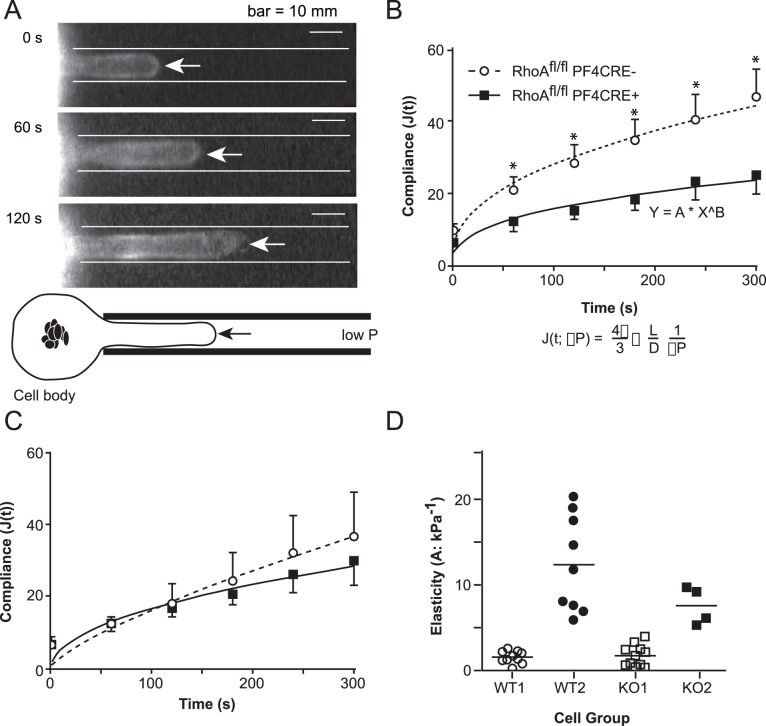
Large RhoA-null megakaryocytes are less compliant than normal sized megakaryocytes.(A) Pictured are representative cells being aspirated with micropipettes (ΔP 0.3–5.7 kPa) causing the cell membrane protrusion (arrows) to extend in length over time. Compliance (J) was computed from the length of the protrusion, and plotted as a function of time. This data exhibited power law behavior: J(t) = A*(x/x0)∧B, where A determines elasticity and B determines rheostatic properties. (B) When the data was not normalized by size, RhoAfl/fl PF4CRE+ derived megakaryocytes were less compliant than the control RhoAfl/fl PF4CRE− derived megakaryocytes at all times tested. Paired t-test analysis demonstrated that P<0.05 for time points indicated by a "*". (C) When only similarly sized megakaryocytes were compared (large controls vs. KO), RhoA-null megakaryocytes had similar compliance curves to that of their controls. Control RhoAfl/fl PF4CRE−: n = 25. RhoAfl/fl PF4CRE+: n = 22. Shown is the mean ± standard deviation for three independent experiments. Paired t-test analysis demonstrated that P>0.05 at all analyzed time points. (D) The basis for normalizing elasticity with size was established as control megakaryocyte elasticity was bimodally distributed, segregating into two groups, WT1 and WT2. Based upon the WT threshold criterion for elasticity, RhoA-null megakaryocytes (KO) were segregated into two groups, KO1 and KO2. The differences in membrane compliance can be entirely accountable by the differences in the sizes of wild type and mutant megakaryocytes.